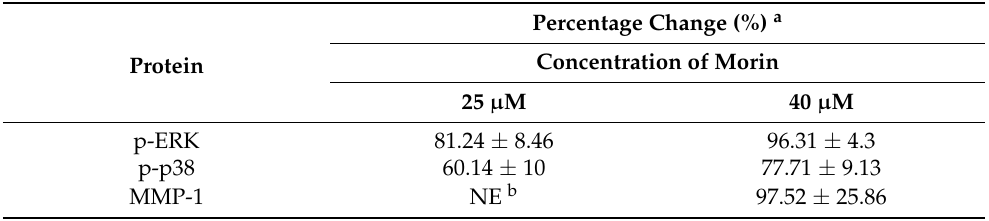
Table 2. Percentage change of p-ERK, p-p38 and MMP-1 expression in PM-induced HaCaT cells treated with morin.